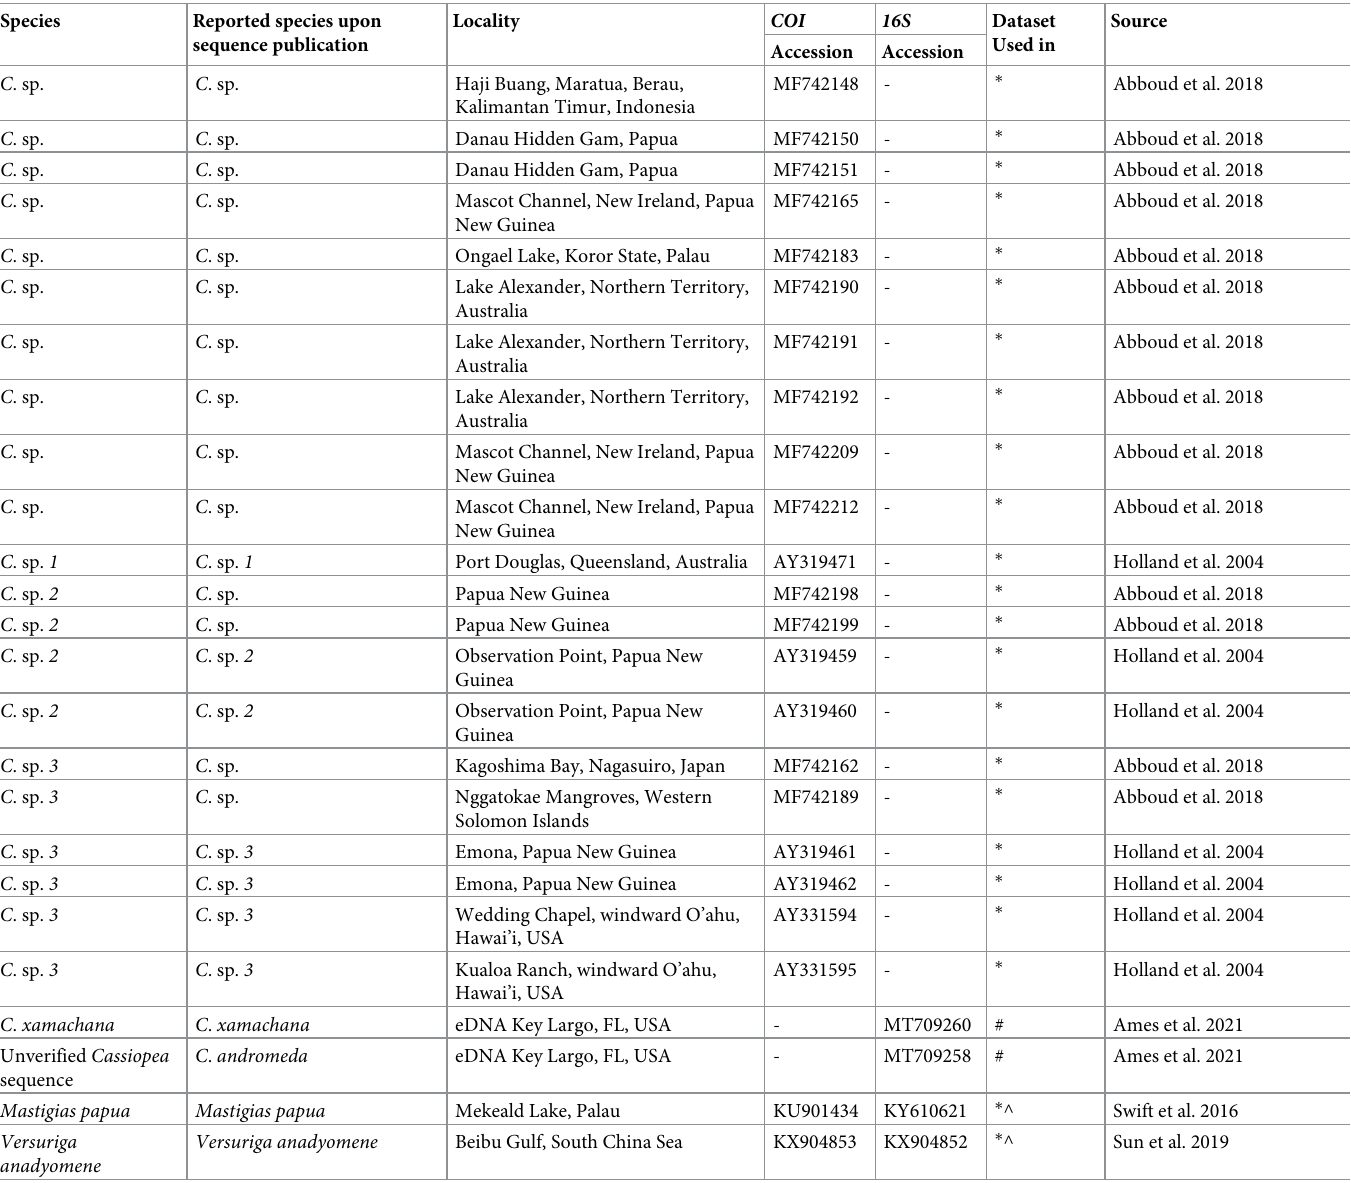
SH-aLRT (approximate likelihood ratio test) and 1000 non-parametric bootstraps under the Mega X model tester suggested model (TN93 + G) and edited in Figtree v1.4. Haplotype networks. All 55 COI sequences from this study and 29 additional GenBank COI sequences belonging to C . xamachana and C . andromeda were used to generate a